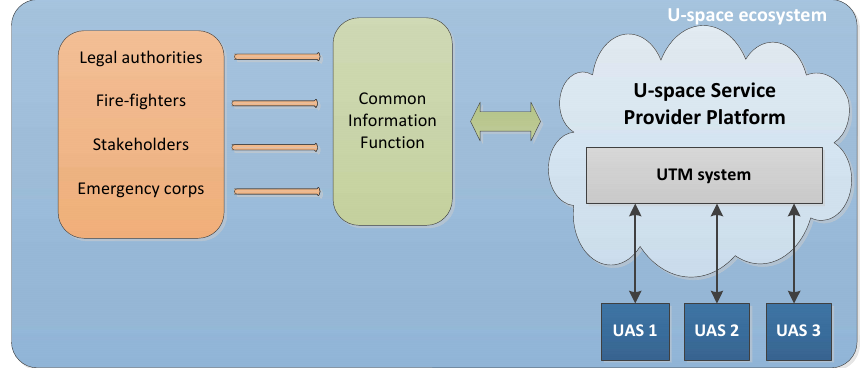
Figure 1. Overview of the U-space ecosystem proposed by EASA [12]. The UTM system offers U- space services to the different actors and runs on a remote server called U-space Service Provider Platform.